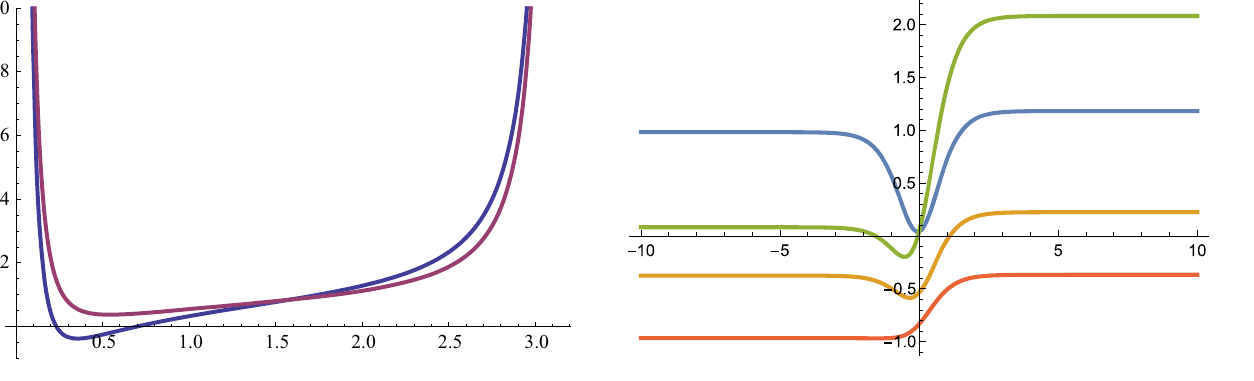
ρ(χ)/ 3 for S ρ(χ)/ 3 for S Fig. 2 Plot of metric function − 8 π R 2 Fig. 1 Plot of metric function 8 π R 2 3 -II. (i) RN black- 3 -I. (i) RN black- 0 0 hole type solution: K = 1, Q = 1, R 0 = 0 . 4. (ii) Schwarzschild hole type solution: K = 0 . 9, Q = 1, R 0 = 1. There are two horizons black-hole type solution: K = 0 . 3, Q = 1, R 0 = 0 . 6. (iii) Nonstatic between which the spacetime is nonstatic. There exist two curvature solution: K = 0 . 1, Q = 1, R 0 = 0 . 4. (iv) Regular solution: K = 0 . 3, singularities. Neither of them is accessible except by radial null rays. Q = 1, R 0 = (ii) Naked singular solution: K = 5 / 9, Q = 1, R 0 = 1